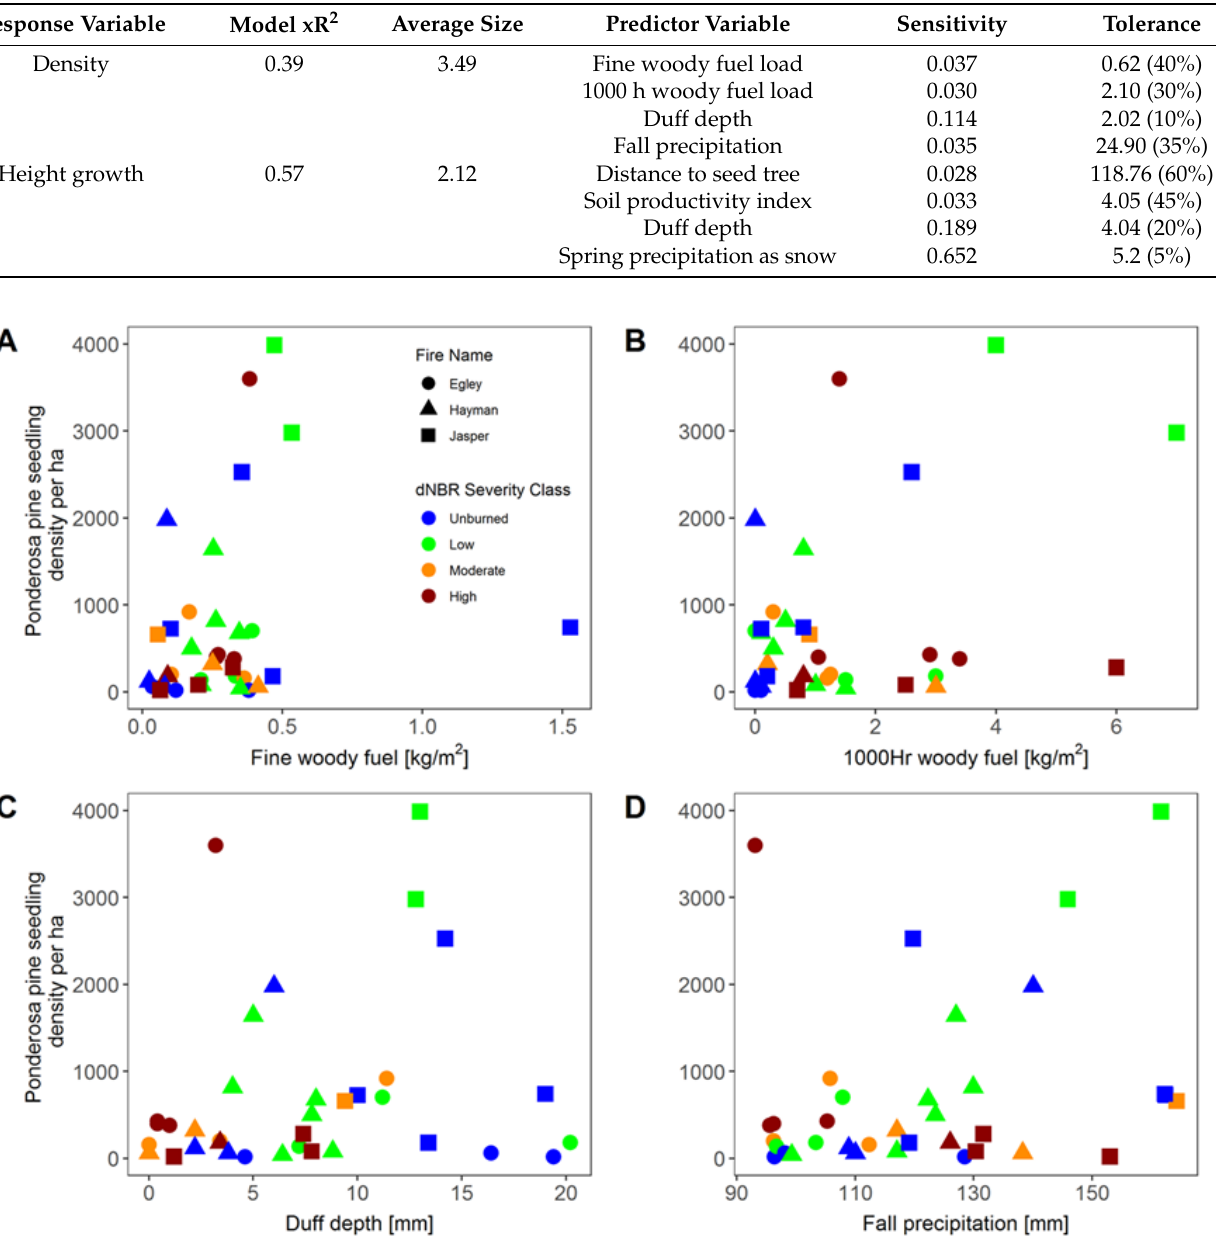
Table 2. Selected best models from non-parametric multiplicative regression (NPMR) free search for ponderosa pine seedling density and standardized height growth following large wildfires. Average size is the average neighborhood size, i.e., the average number of sample units that contribute to each point’s estimated value on the modeled surface. See Table 1 for variable units and ranges.